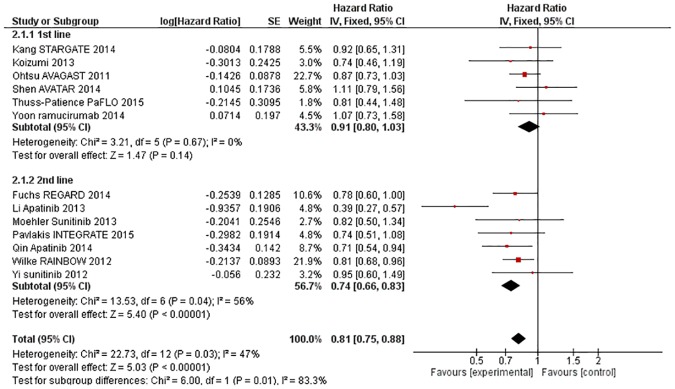
Forest plot—Overall Survival—by line of therapy.